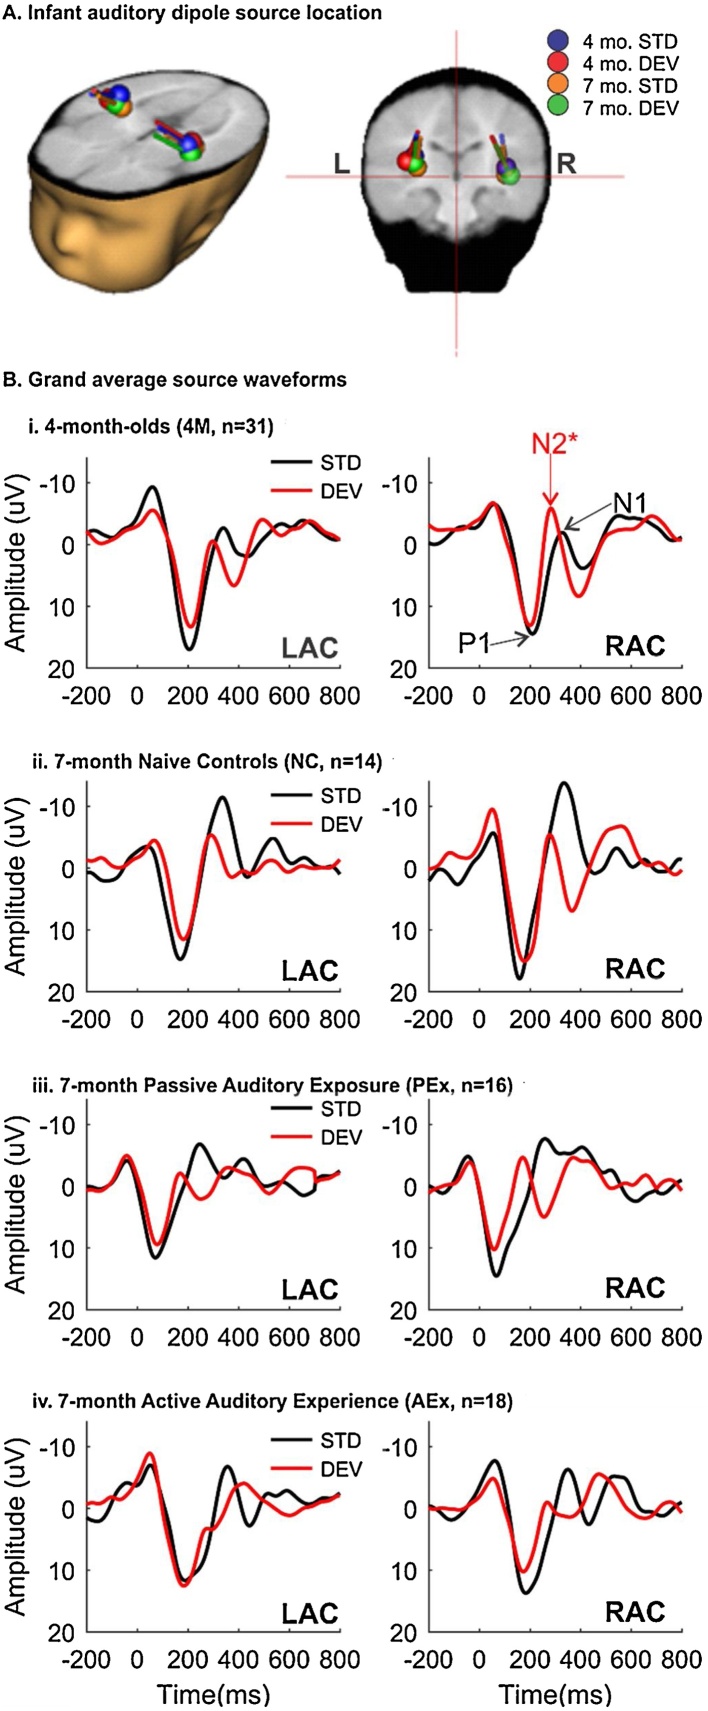
Left and Right Auditory Cortex (LAC, RAC) source locations and waveforms. A. LAC and RAC source localized dipoles are overlaid on the infant MRI template for 4- and 7-month old infants. For the 4-month group, standard (STD) stimulus is shown in blue and deviant (DEV) stimulus is shown in red. For the 7-month group, standard (STD) is shown in orange and deviant (DEV) is shown in green. Locations are not significantly different between 4 and 7 months-of-age. B. Grand average LAC and RAC source waveforms to the Standard, frequency invariant stimulus (STD, black) and the Deviant stimulus with rapid frequency change (DEV, red). STD Waveforms are characterized by a large positive peak ∼150 ms (P1), followed by a negative peak ∼350 ms (N1). P1 peak latencies and amplitudes to DEV stimuli are similar to STD across 4- and 7-month groups (i–iv). DEV stimuli elicit change complex (N2*), which changes in latency and morphology according to age and experience. (For interpretation of the references to color in this figure legend, the reader is referred to the web version of this article.)